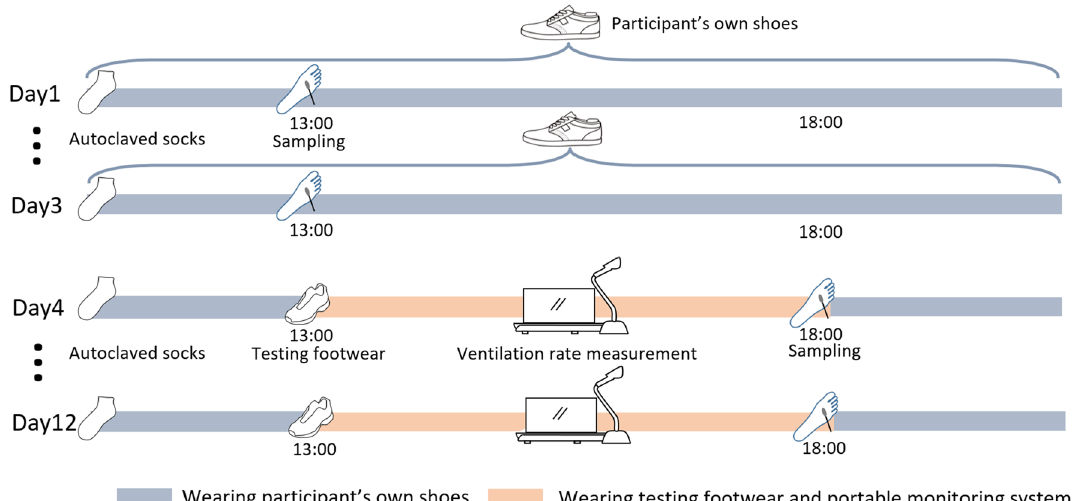
Figure 1. Schematic of procedures for the whole 12-continuous-day experiment (Day 1–Day 3: wearing the participant’s own shoes; Day 4–Day 12: wearing each testing footwear for three consecutive days). The testing order of the three footwear types was balanced (Participant A: 1. perforated shoes; 2. casual shoes; 3. running shoes; Participant B: 1. running shoes; 2. perforated shoes; 3. casual shoes; Participant C: 1. casual shoes; 2. running shoes; 3. perforated